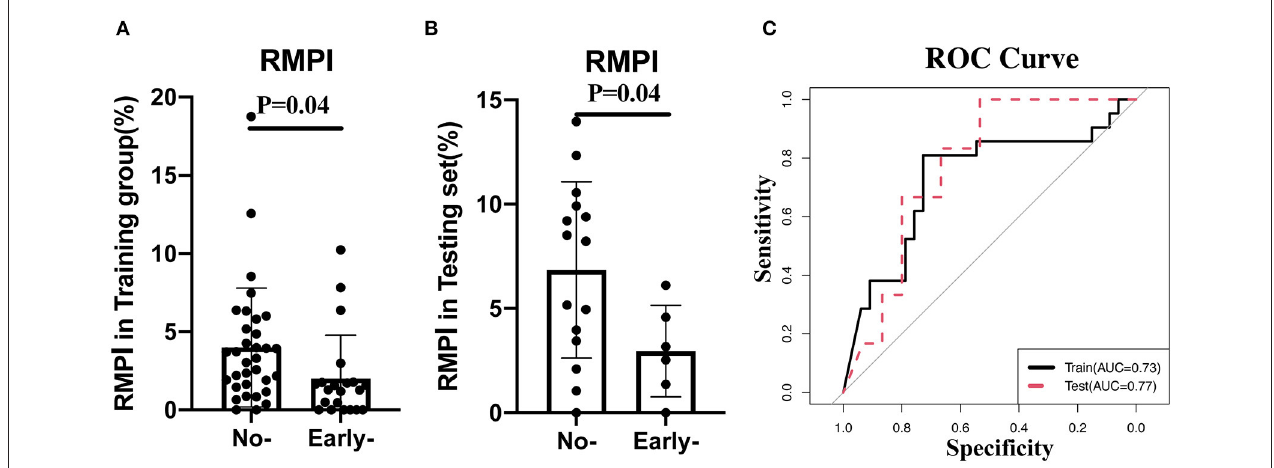
FIGURE 1 | Validation of RMPI in the testing cohort. (A,B) The expression pattern of RMPI in the training and testing groups. (C) RMPI achieved discriminative power in the training group and testing set. RMPI, the ratio for infarction volume in midbrain and pons.